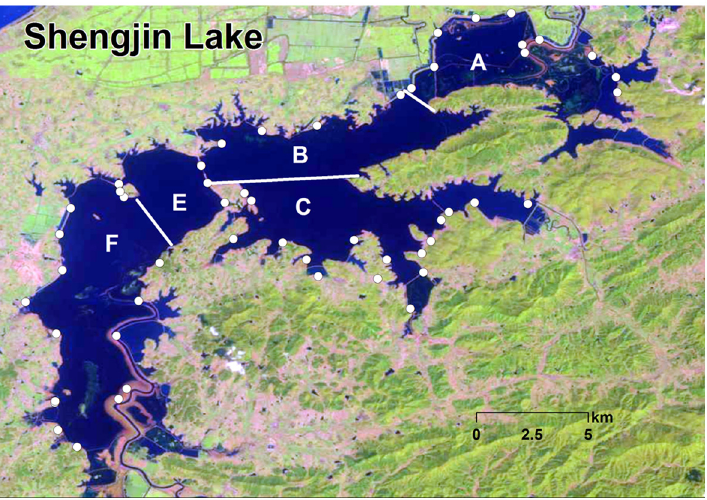
Fig 1. Map of Shengjin Lake and the five discrete survey areas. The white circles indicate the 56 counting points and the white lines indicate the counting area boundary (Source:http://eros.usgs.gov/#).